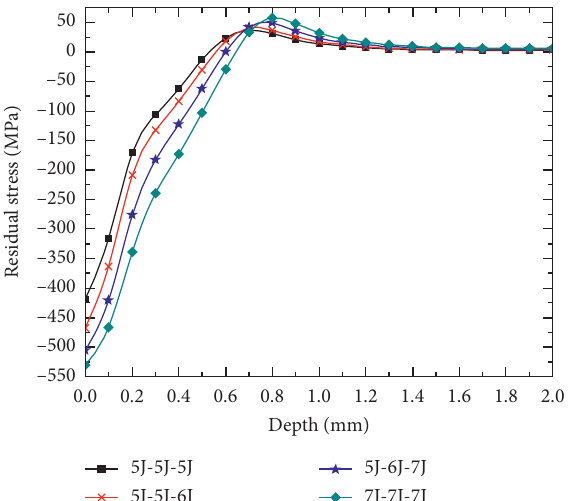
Figure 17: Curves of residual stress distribution of the in-depth direction of sample surface with three different laser